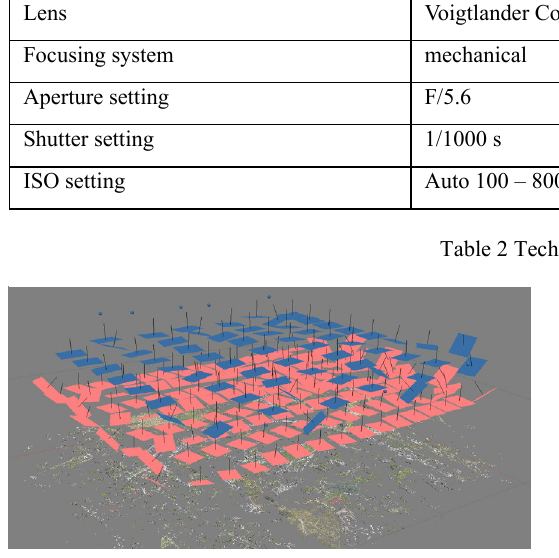
Figure 3 Cross flight configuration - variant 6 (Sony RX1RII) Final flight configuration variants were as follow: